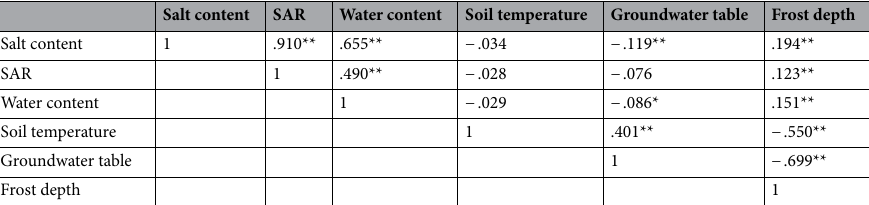
Table 6. Correlations between soil salinity, alkalinity, soil water, soil temperature, groundwater table and frost depth. **Correlation is significant at the 0.01 level (2-tailed). *Correlation is significant at the 0.05 level